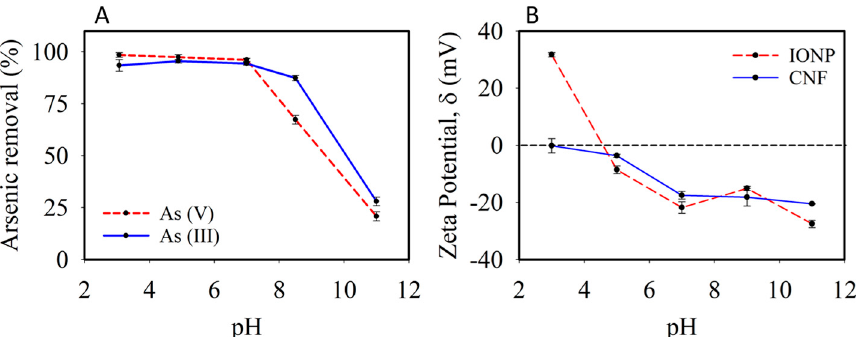
Figure 3. Effect of pH on arsenic removal percentage. Initial arsenic ion concentration: 1 mg L –1 , IONP dosage: 63 mg of IONP L –1 ( A ) and zeta potential measurements of CNF and IONP suspen- sions at different pH values ( B ). Error bars represent standard deviation from triplet measurements.